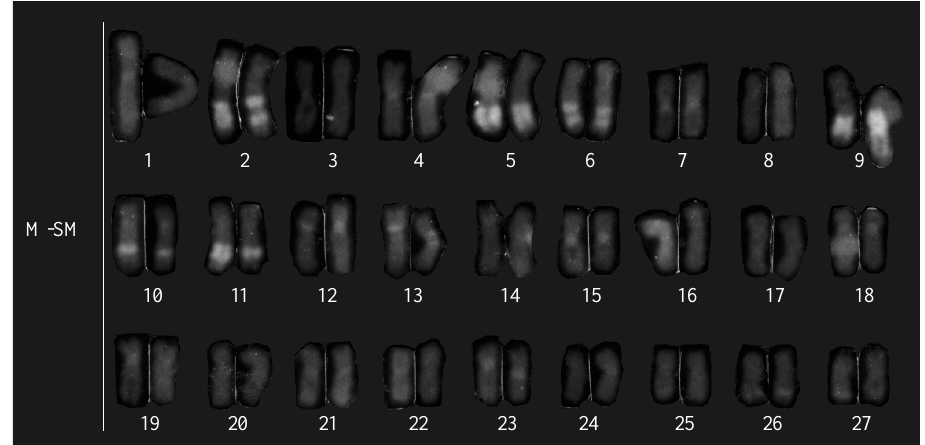
Figure 2 - Karyotype of Leporinus desmotes female stained with mithramycin.